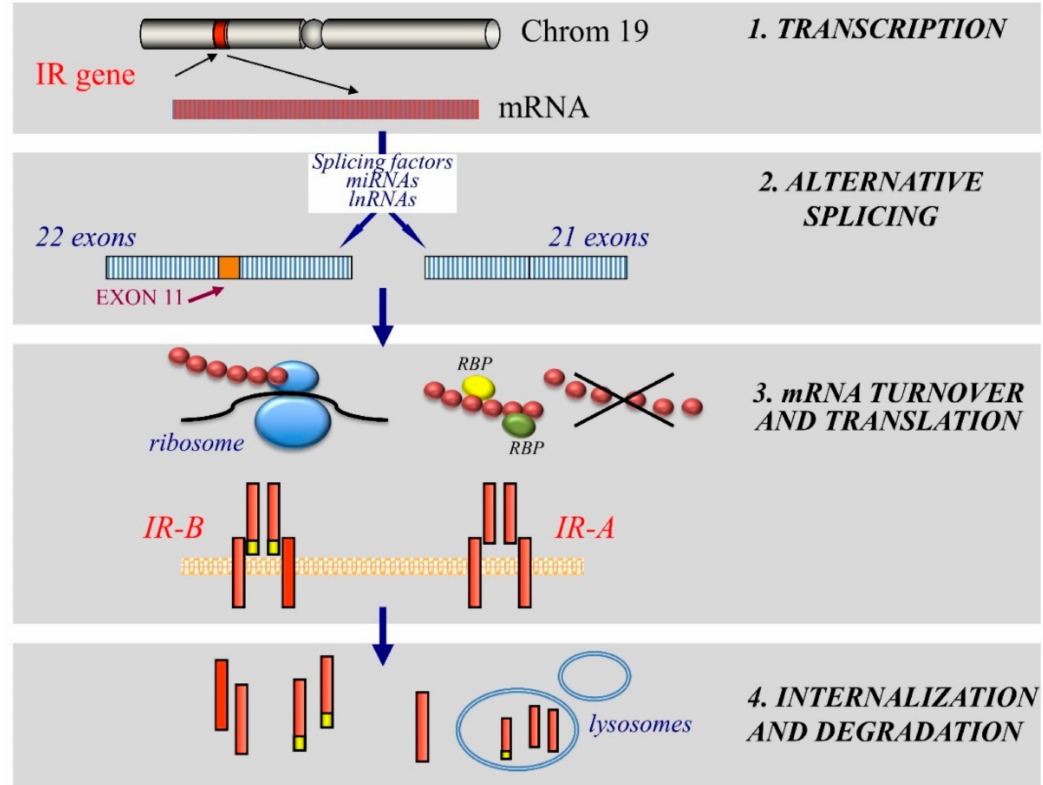
Figure 2. Schematic representation of mechanisms regulating the expression of IR isoforms. The figure summarizes the principal phases determining the level of the total cellular IR content and the relative IR isoform expression. (1) Transcription regulation: The balance between stimulatory and inhibitory transcription factors plays an important role in regulating IR gene transcription in chromosome 19; (2) Alternative splicing: At post-transcriptional level alternative splicing of the IR mRNA transcript (including or excluding exon 11) regulates the IR isoform relative abundance. Different modulators, such as splicing factors, miRNAs and lnRNAs are involved; (3) mRNA turnover and translation: The stability of IR mRNAs and its translation into the IR protein by ribosomes is regulated by the RNA binding proteins (RBPs); (4) Internalization and degradation: IR isoforms undergo internalization and protein degradation by ubiquitination at a different rate, through a process that facilitates endocytosis and endosomal degradation. The ligand binding feature is an important determinant of this